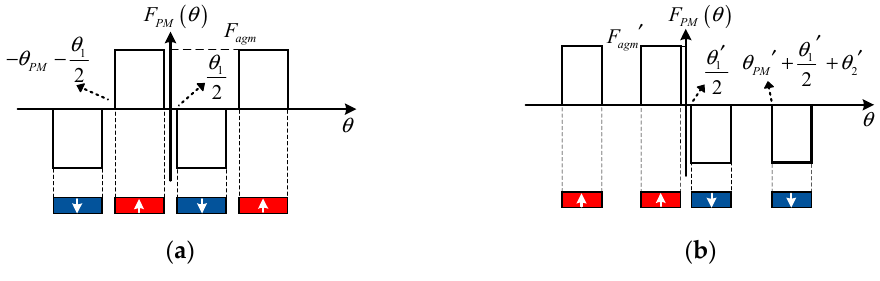
Figure 4. PM MMF distribution. ( a ) CPMM. ( b ) DHPCM-SPMPs.